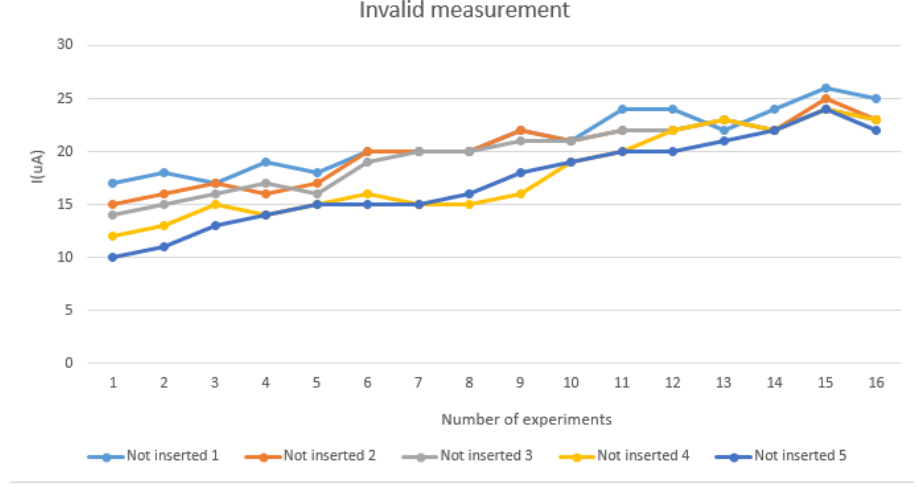
Figure 15. Invalid measurement.